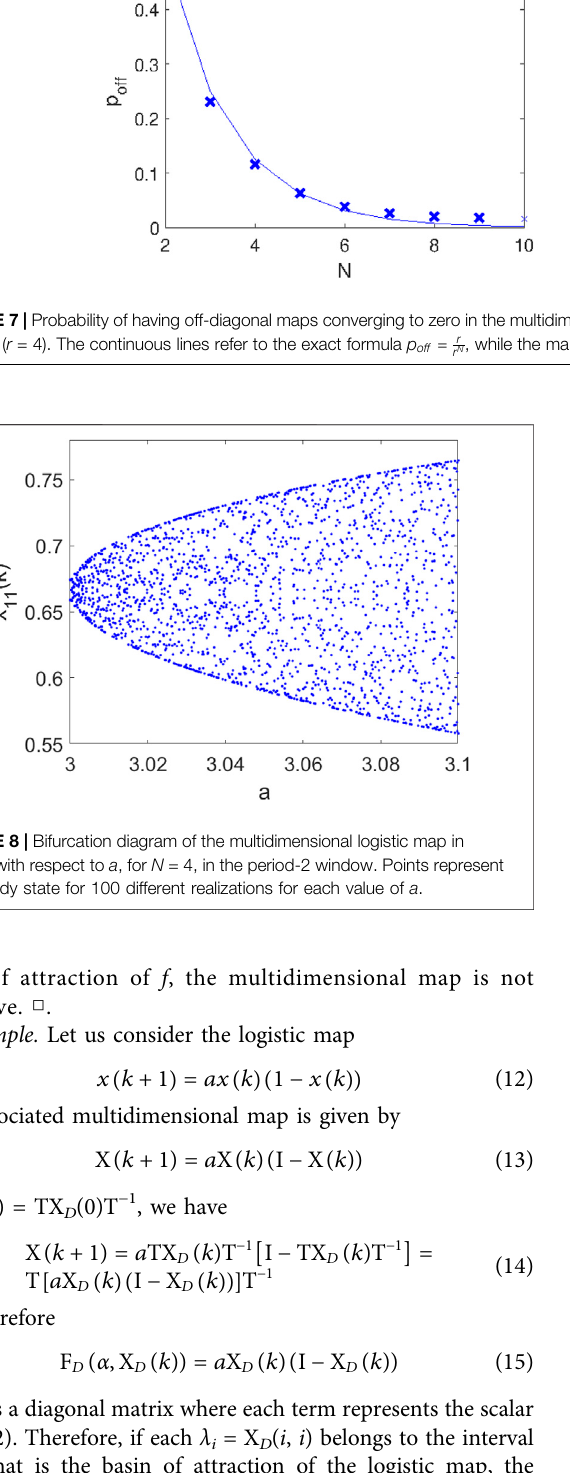
Frontiers in Physics |